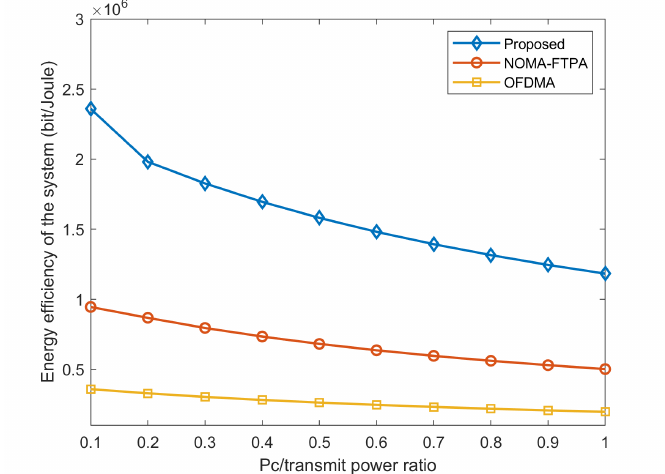
Figure 6. Energy efficiency of the system versus P c /transmit power